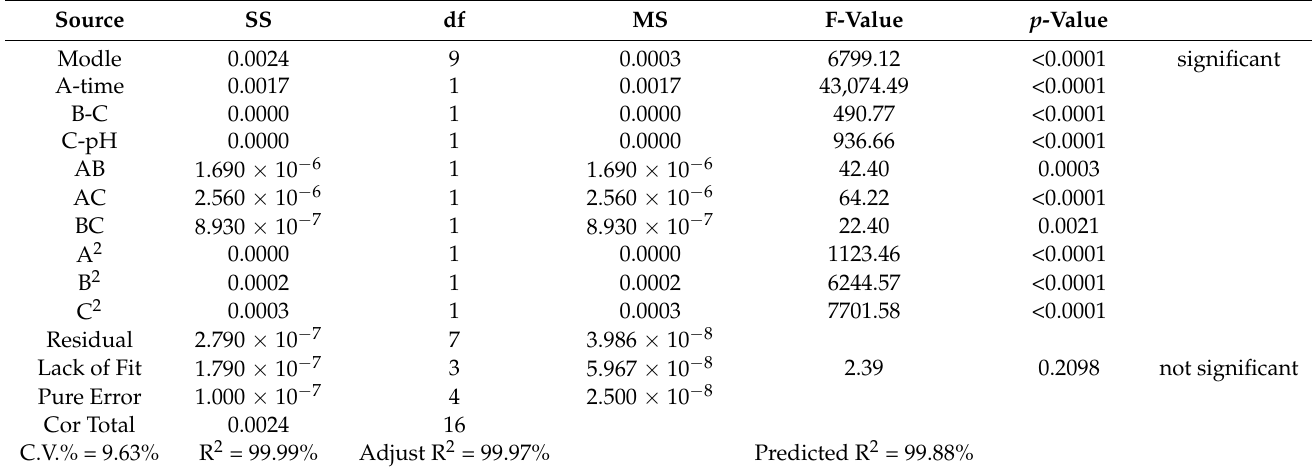
Table 1. ANOVA table for the boric acid adsorption capacity on the meglumine-functionalized modified graphene oxide/carbon nanotube